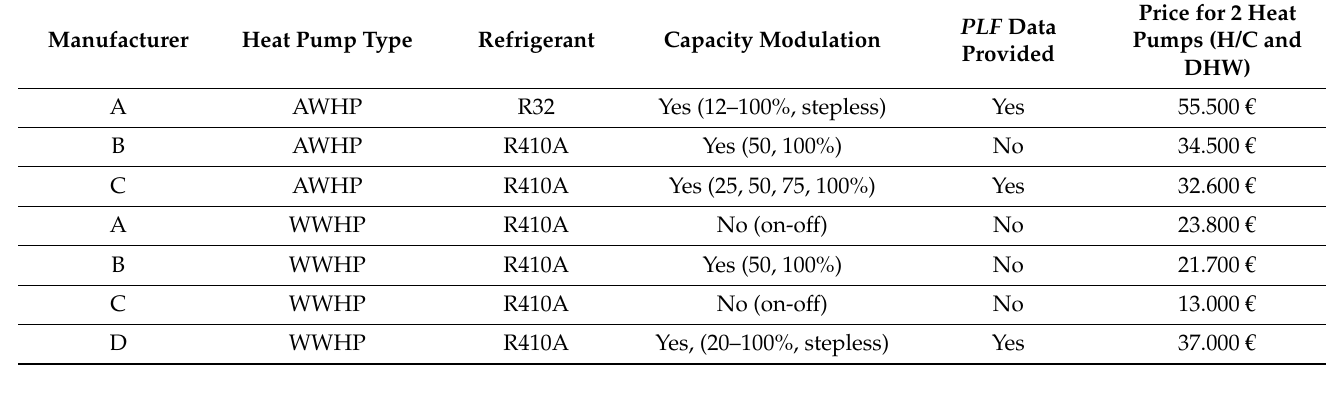
Table 4. Investment cost, possibility for capacity control and provided PLF data for heat pump units considered in the analysis.